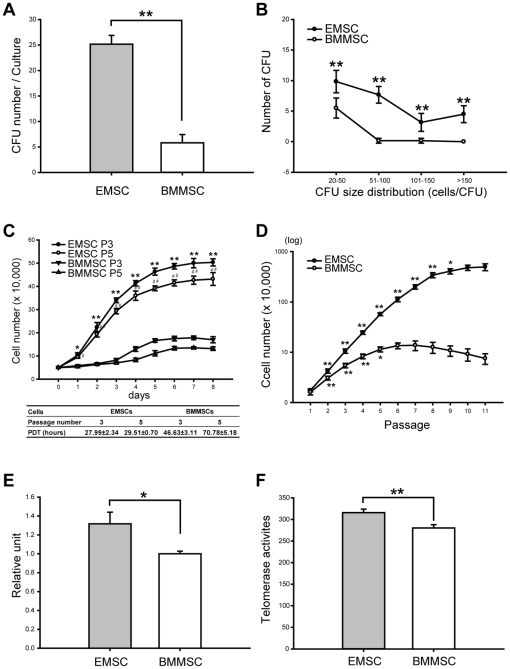
Cell proliferation profiles of EMSCs and BMMSCs.(A) Colony-forming activity of EMSCs and BMMSCs at the first passage. EMSCs formed 23.17±2.92 CFUs whereas BMMSCs formed 5.83±1.60 CFUs (n = 6). (B) CFUs size distribution for EMSCs and BMMSCs. EMSCs formed more and larger CFUs than BMMSCs. ** represents P<0.01 (n = 6). (C) PDTs for EMSCs were compared to BMMSCs at the third (P3) and the fifth (P5) passages. The curves of EMSCs are higher than the ones of BMMSCs (n = 3). * represents P<0.05, ** represents P<0.01, which was compared at the third passage. # represents P<0.05, ## represents P<0.01, which was compared at the fifth passage. (D) Propagating abilities of EMSCs and BMMSCs. Cells were propagated for 2 days at each passage and cell numbers were calculated. EMSCs could be propagated for more passages that cells still retained proliferation ability than BMMSCs (n = 5). * represents P<0.05, ** represents P<0.01, as compared to previous passage. (E) Telomere length and (F) telomerase activity of EMSCs and BMMSCs (at the first passage) were detected and compared. EMSCs expressed significantly longer telomere length and higher telomerase activity than BMMSCs (n = 3). * represents P<0.05, ** represents P<0.01. Data are presented as mean ± s.d. and analyzed with Student's t-test.